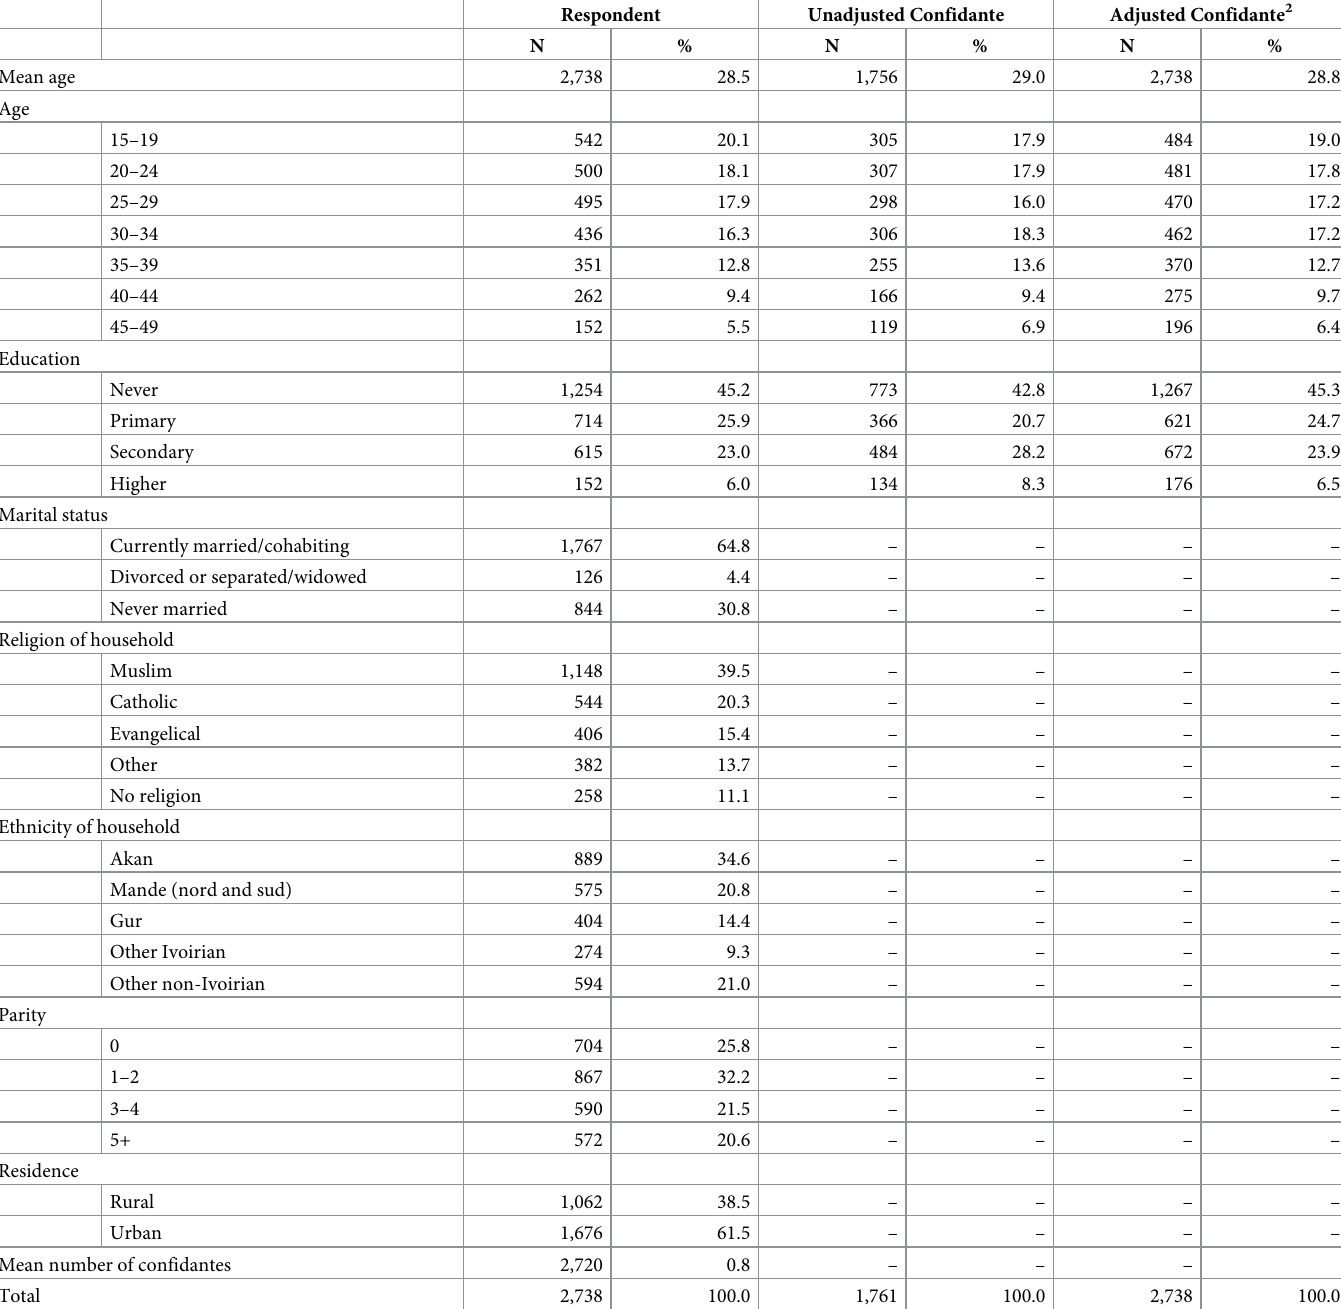
Table 1. Characteristics of female respondents age 15 to 49 and their closest female confidantes age 15 to 49 in Coˆte d’Ivoire 1